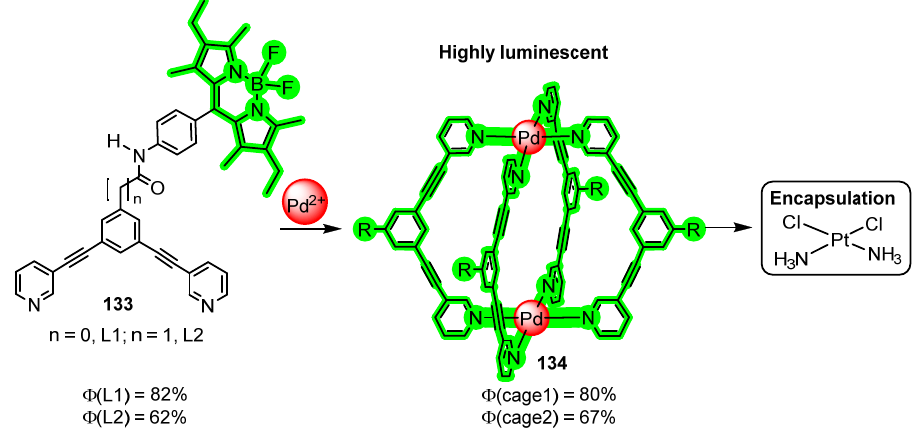
Figure 38. Schematic representation of the selective synthesis and structure of BODIPY − containing lantern − type cages Pd 2 L 4 134 , able to encapsulate cisplatin. Adapted from [115].